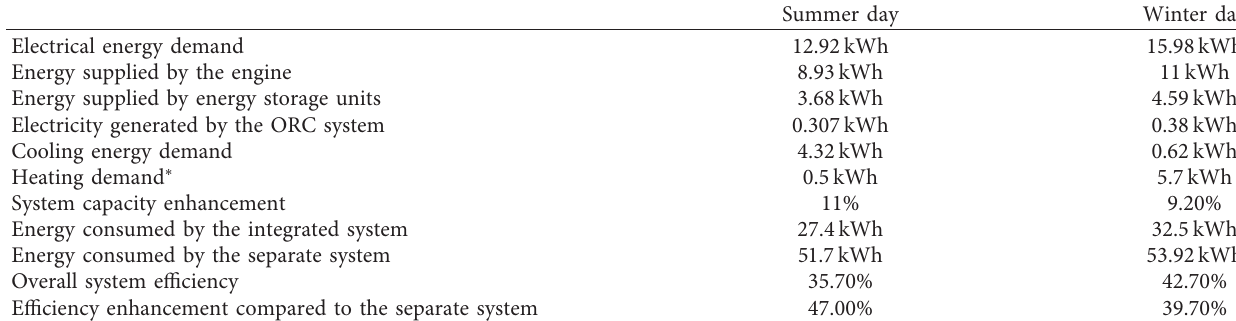
Table 5: Key parameters displaying in the two set of